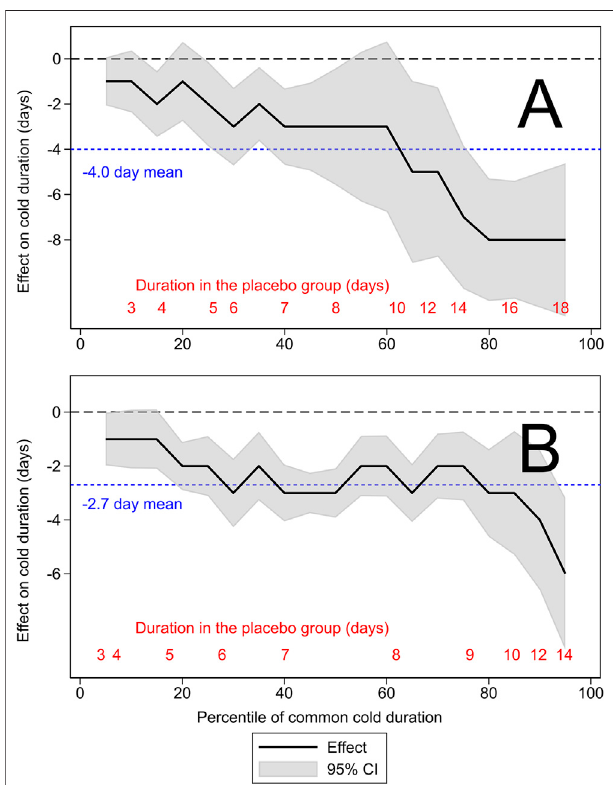
FIGURE 2 | The quantile treatment effect (QTE) of zinc lozenges on common cold duration. (A) The Mossad et al. (1996) trial and (B) the pooled results of three zinc acetate lozenge trials (Petrus et al., 1998; Prasad et al., 2000; Prasad et al., 2008). The horizontal axis shows the distribution of the duration of colds by percentiles. The continuous black lines indicate the QTEofzinclozengesandthegrayshadowindicatesits95%CI.Thehorizontal black dashed lines indicate the null effect. The blue dotted line in panel (A) shows the previously calculated 4.0-day mean effect in the Mossad trial (Hemilä,2017),andinpanel (B) showsthe2.7-daymeaneffectofzincacetate lozenges (Hemilä et al., 2016). The red fi gures at the bottom indicate the lowest percentile level for the indicated common cold duration in the placebo group. For example, in panel (B) , the 7-day colds cover the percentile range from 40th to 62nd, which corresponds to 21 patients, as the total number of patients in the placebo groups was 97. The program used for the generation of this fi gure is shown in the Supplementary Material